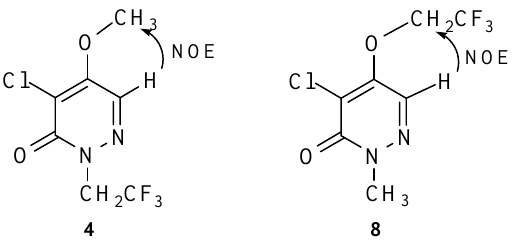
Figure 1 . NOE between H-6 and methyl or trifluoroethyl group in compound 4 or 8